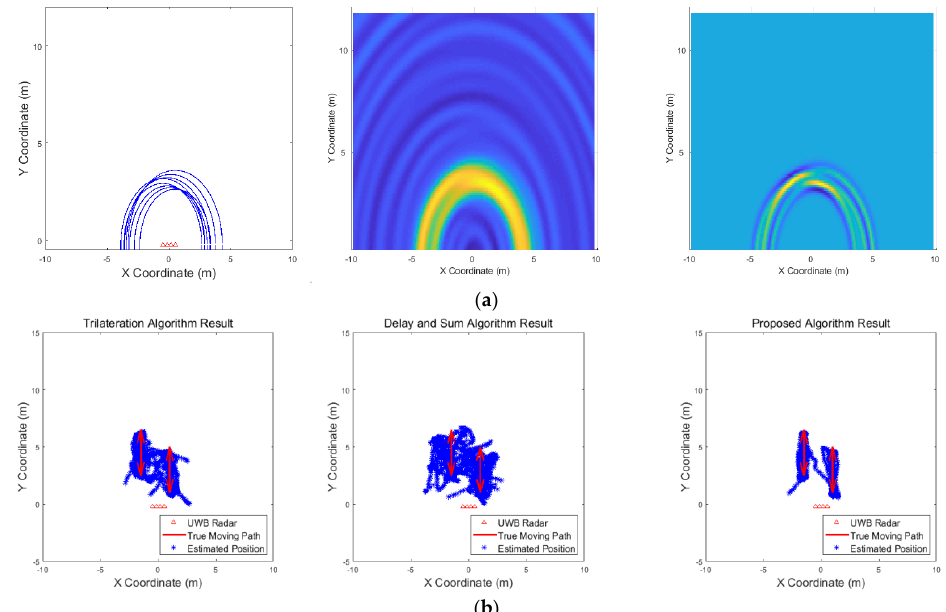
Figure 12. Simulation results when two targets stand close each other (Scenario 4): ( a ) instantaneous results of position estimation step according to the positioning algorithm; ( b ) results of the radar system for the entire simulation.